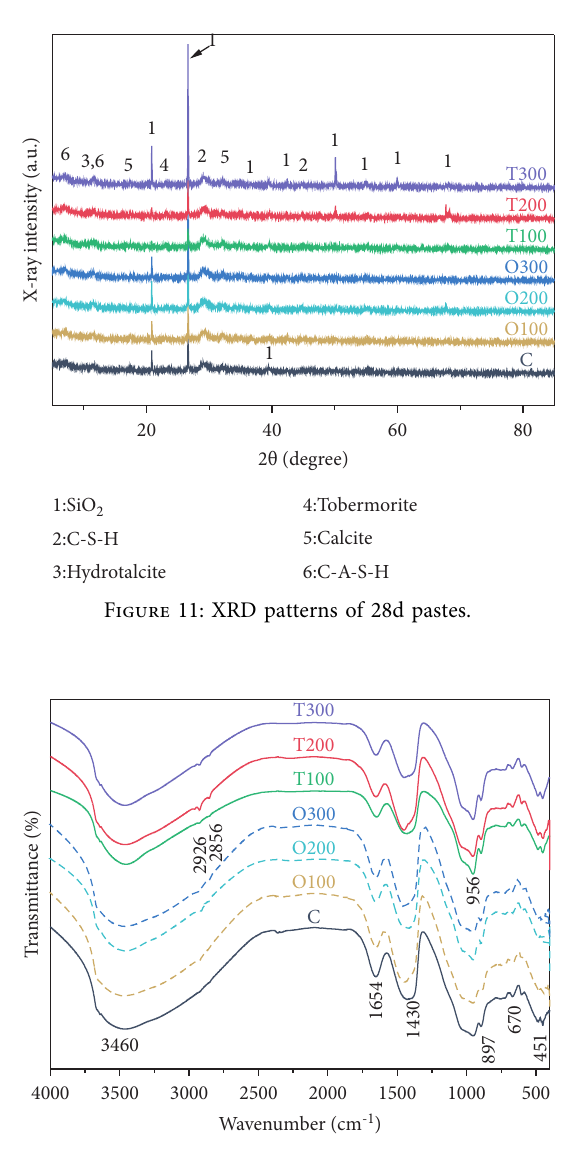
Figure 12: FT-IR spectra of mortar under different